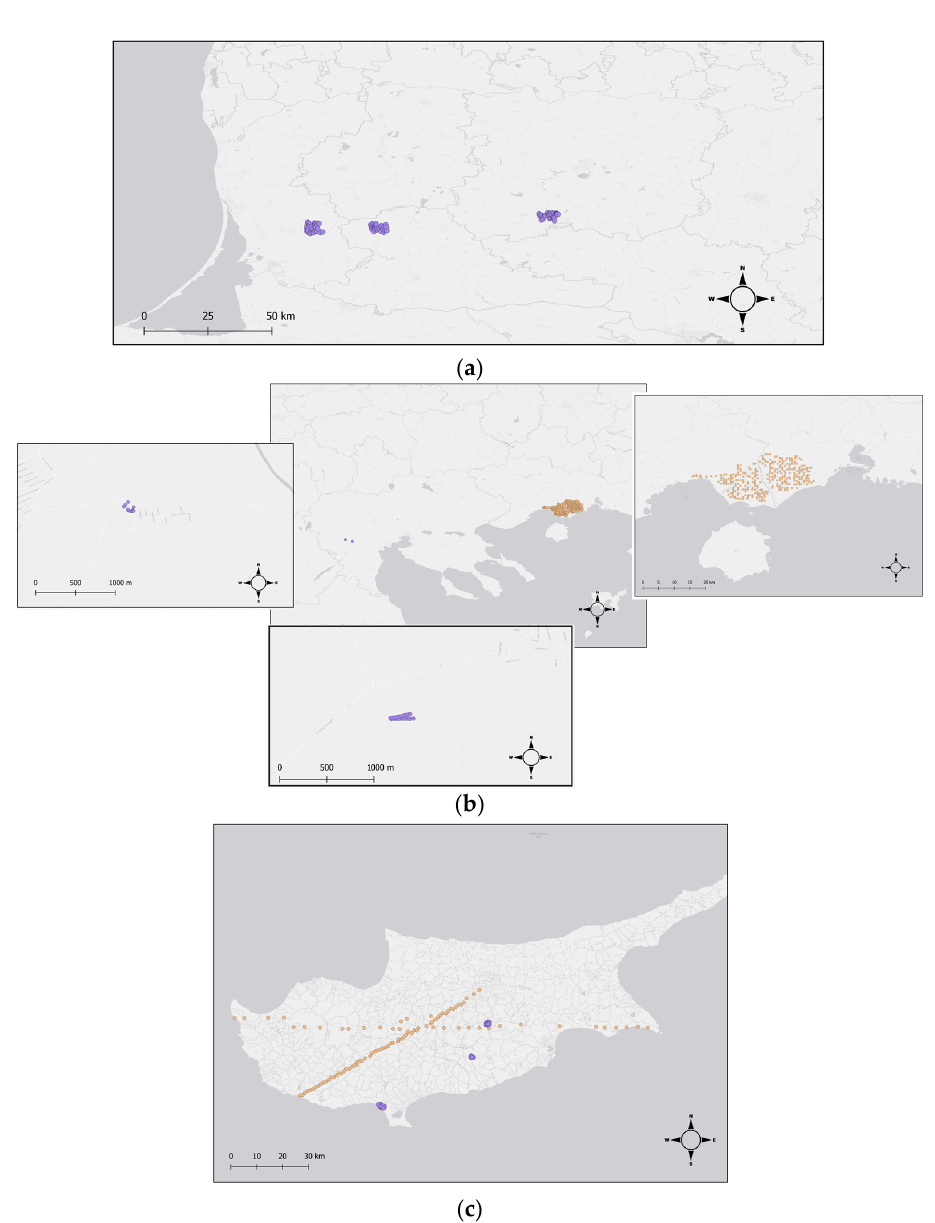
Figure 2. Spatial distribution of the sampling locations (purple) and GEO-Cradle samples (yellow) in ( a ) Lithuania, ( b ) Greece, and ( c ) Cyprus. ( a ) Lithuania, ( b ) Greece, and ( c )